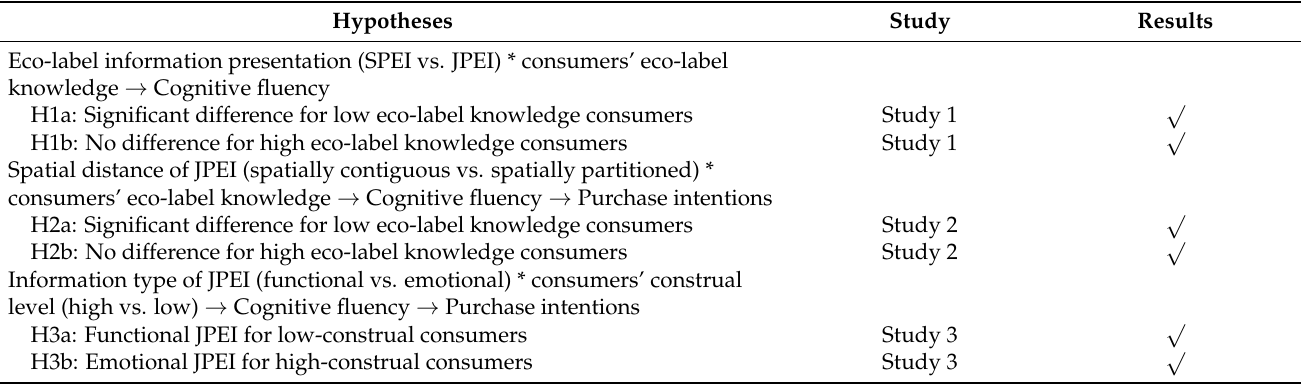
Table 1. Summary of the findings.